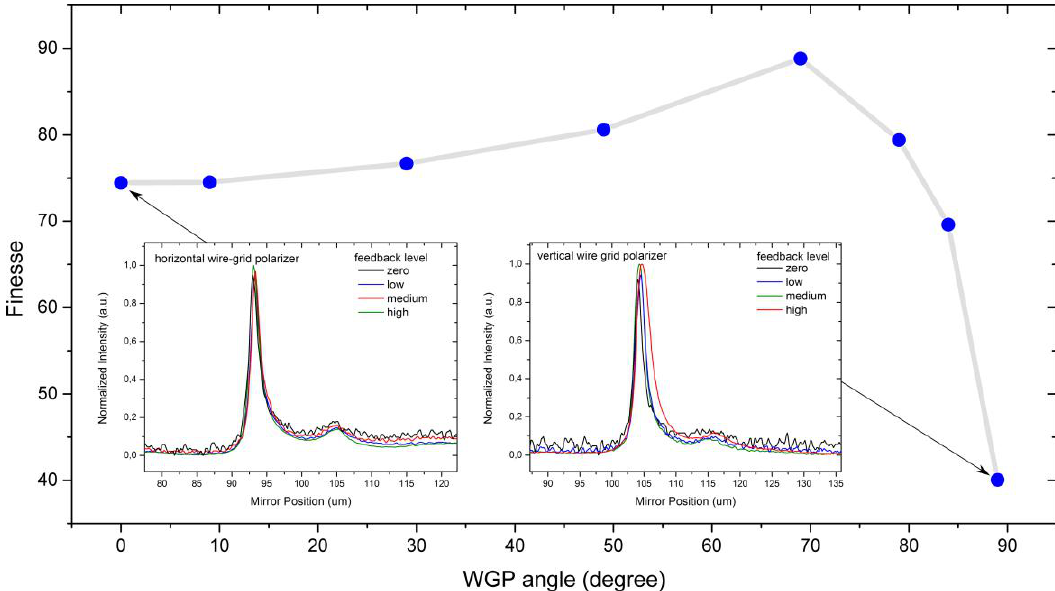
Figure 4. Systematic analysis of the measured BTC finesse for different polarization orientations inside the cavity, i.e., different orientation of the WGP wires. The reported finesse values are still non-perfectly optimized. However, the two effects of optical feedback (OF) and additional cavity losses are visible. The insets show in detail the analysis of the peak width for different beam attenuations, corresponding to different feedback levels, when the wires of the WGP are vertically (inset-right) and horizontally (inset-left) oriented.